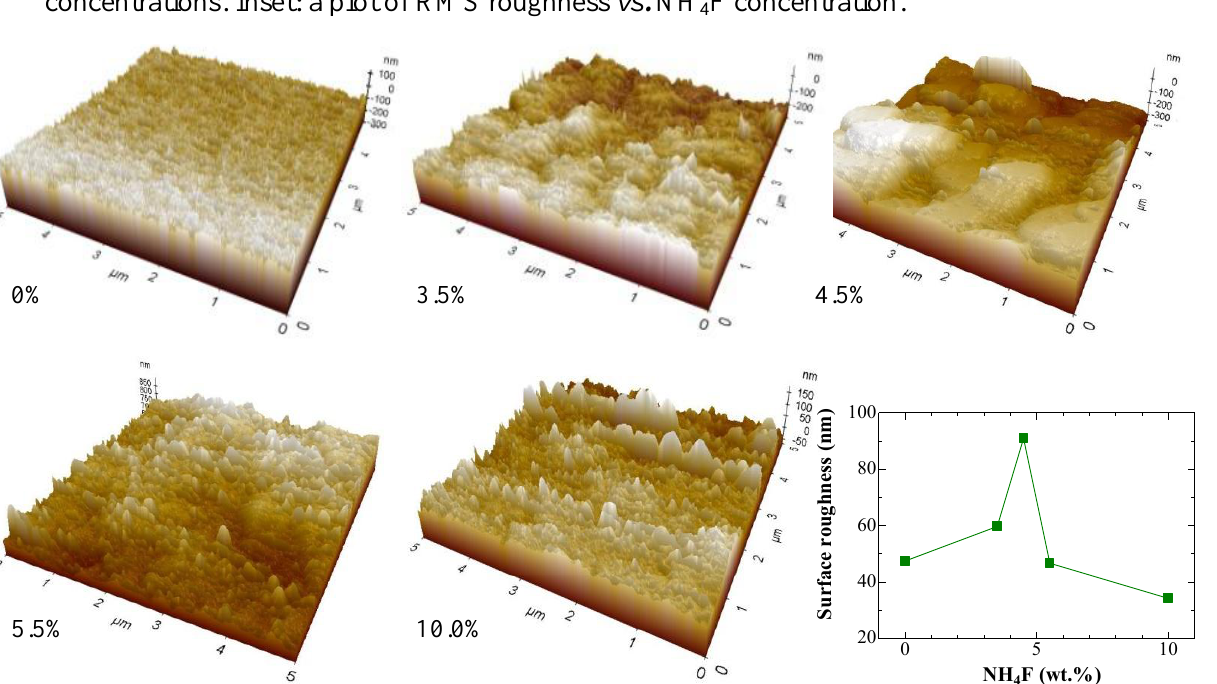
Figure 3. Three-dimensional AFM images of SnO concentrations. Inset: a plot of RMS roughness vs. NH